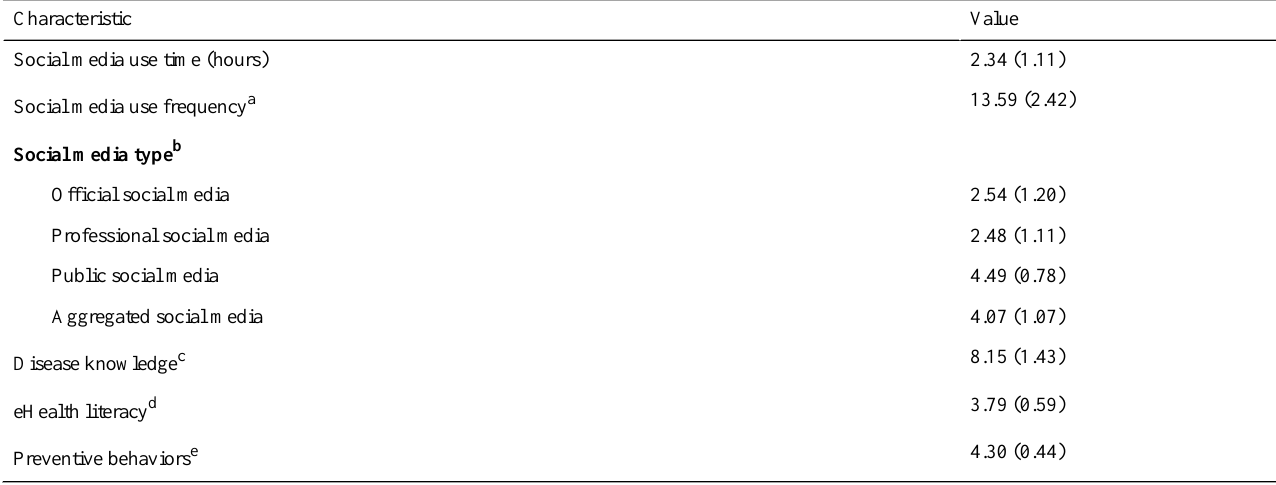
Table 2. Characteristics of social media use, disease knowledge, eHealth literacy and preventive behaviors (N=802), mean